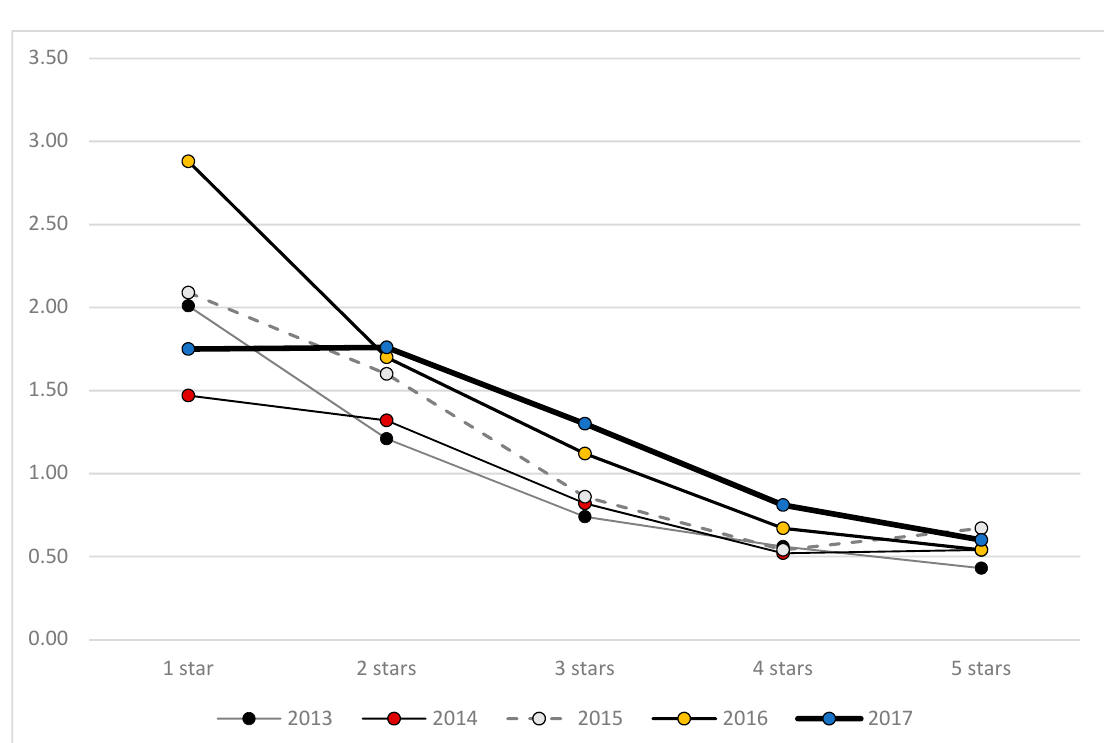
Figure 8. Quick Ratio, by the number of stars. Table 12. Log-linear regression of Current Ratio.